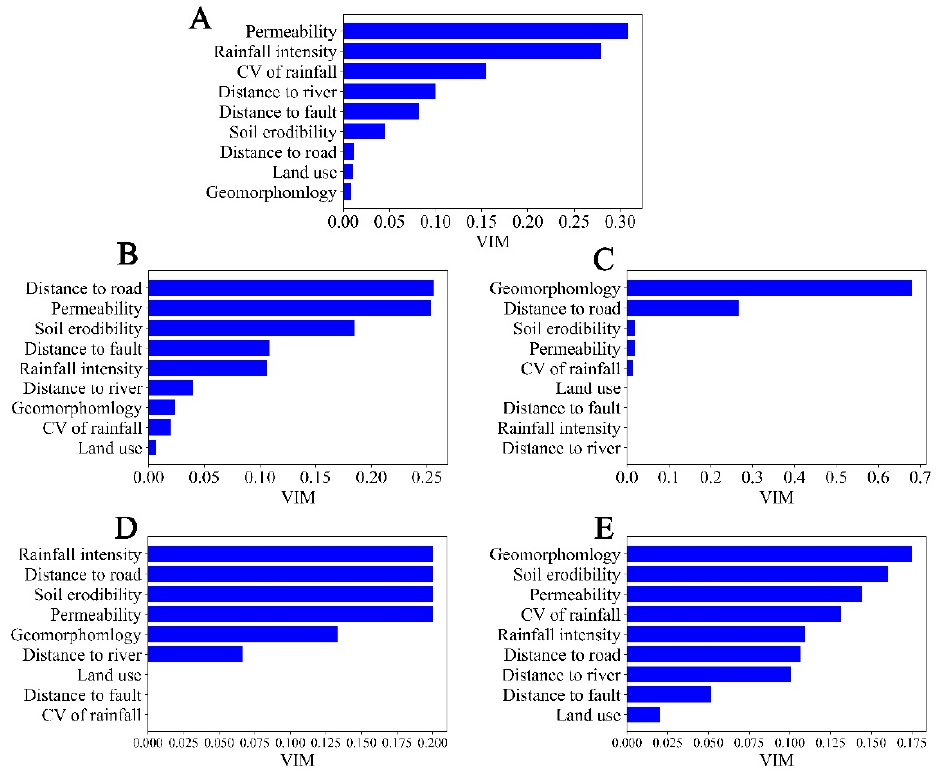
Figure 8. Relative importance (VIM) of debris flow in Southern Shaanxi ( A ) and collapse ( B , C ) and landslide ( D , E ) in Northern and Southern Shaanxi, respectively.